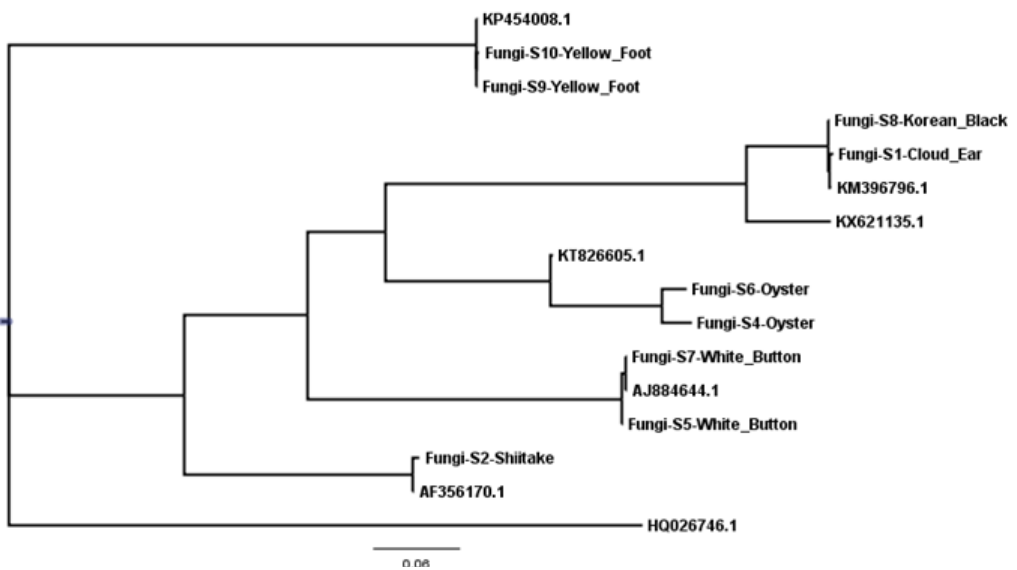
Figure 2. Phylogenetic tree of generated DNA barcodes and closest matching GenBank entries, based on internal transcribed spacer (ITS) sequence diversity. One Aspergillus fumigatus sequence, derived from GenBank (accession number HQ026746.1), was added to the sample data set and selected as an